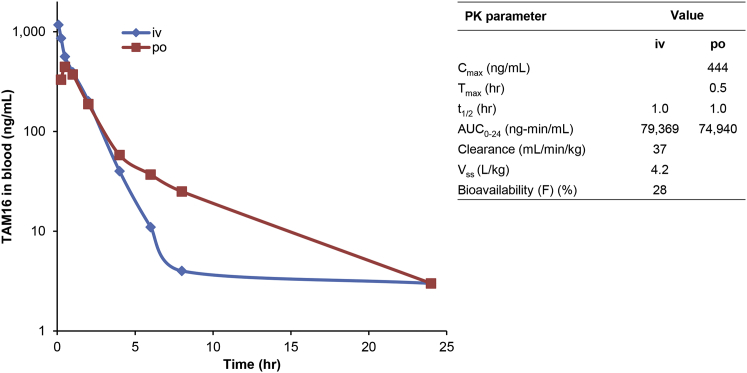
In Vivo Pharmacokinetics of TAM16, Related to Table 3Mean blood concentration profiles of TAM16 following oral (p.o) and iv dose of 10 mg/kg and 3 mg/kg, respectively, in female BALB/c mouse. PK parameters (inset) were determined after the administration of a single dose (both p.o and iv) to mice. Cmax, maximum concentration; Tmax, time to reach Cmax, t(1/2), half-life; AUC, area under the concentration curve; Vss, volume of distribution at steady state.